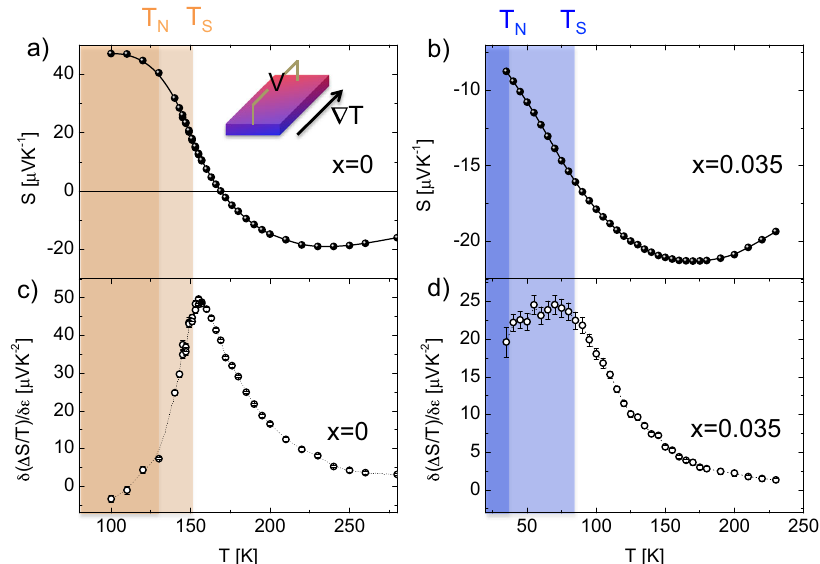
Fig. 2 Elasto-Seebeck effect of the LaFe 1 − x Co x AsO compounds with x = 0 and x = 0.035. a Temperature dependence of the Seebeck coef fi cient S of the LaFe 1 − x Co x AsO compounds with x = 0. b Temperature dependence of the strain derivative of the T -normalized Seebeck coef fi cient δ ( Δ S / T )/ δ ϵ x = 0 compound. c Temperature dependence of the Seebeck coef fi cient S of the LaFe 1 − x Co x AsO compounds with x = 0.035. b Temperature dependence of the strain derivative of the T -normalized Seebeck coef fi cient δ ( Δ S / T )/ δ ϵ x = 0.035 compound. The dark- orange and the dark-blue areas indicate the regions where the long range structural and magnetic ordered states are both established. The error-bars represent the standard errors (see Supplementary Note 7, Supplementary Figs. 7 – 9).